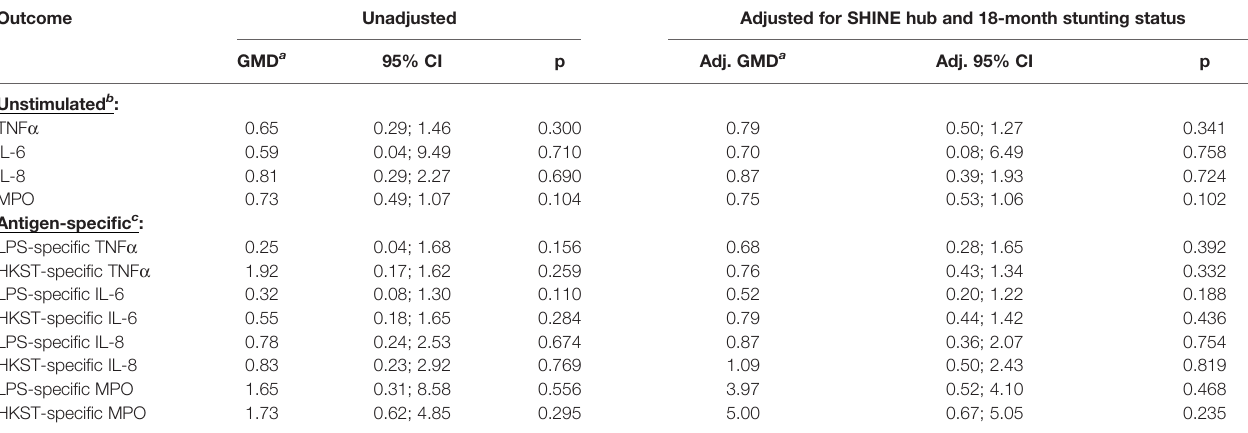
TABLE 5 | Censored log-normal (tobit) regression analysis of the relationship between IYCF intervention arm and immune-mediator production at 18 months of age. Outcome Unadjusted Adjusted for SHINE hub and 18-month stunting status GMD a 95% CI p Adj. GMD a Adj. 95% CI